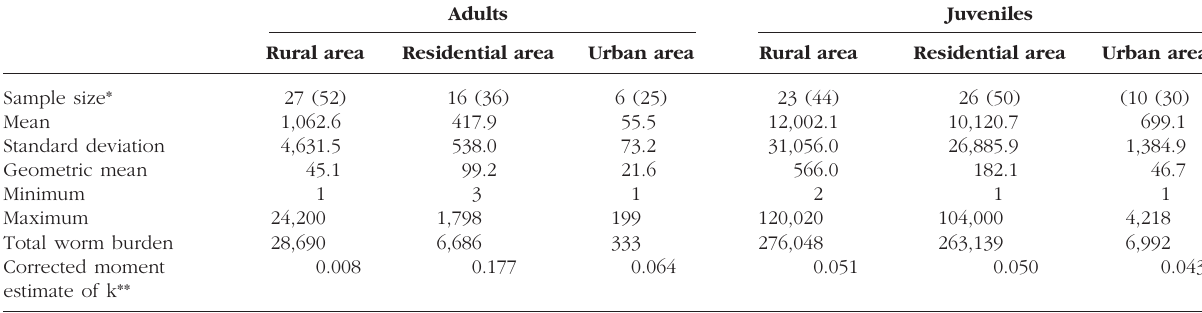
Table II. – Worm burden distribution (intensity of infection) of E. multilocularis along the increasing gradient of urbanization, in Geneva, Switzerland.